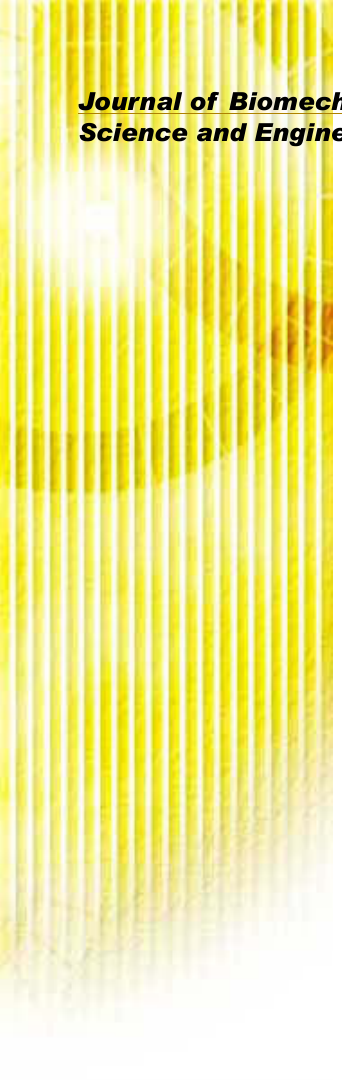
Table 5 Braille Recognition Time by VF , VD and LD